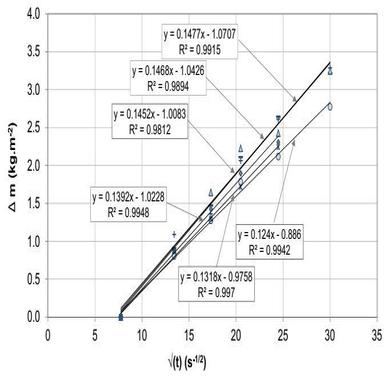
Water mass absorption as a function of square root of time.